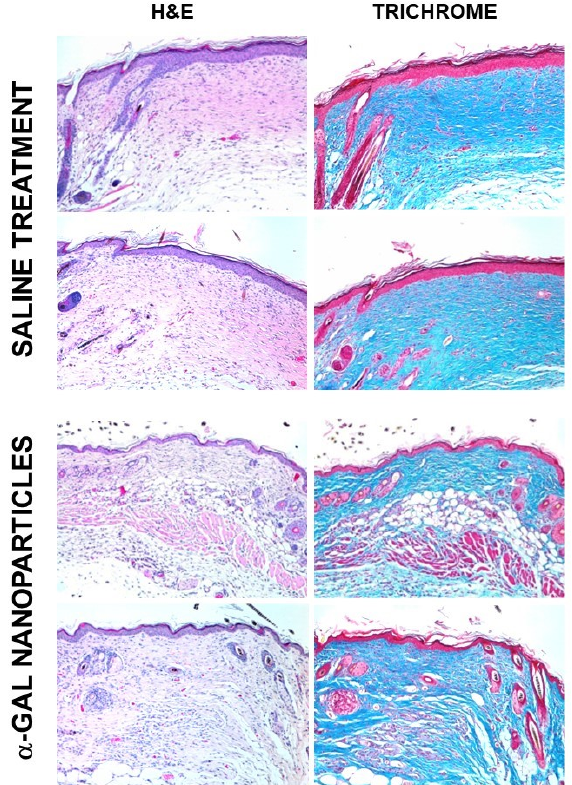
Figure 8. Histology of GT-KO mouse wounds treated with α -gal nanoparticles or with saline and inspected 28 days post treatment. Wounds were stained with H&E or with Masson trichrome for detection of de novo produced collagen. Whereas the saline treated wounds display distinct fibrosis and scar formation (dense connective tissue, hyperplastic epidermis, absence of skin appendages), the α -gal nanoparticles treated wounds display restoration of normal skin structure including growth of hair, loose connective tissue, adipose tissue and smooth muscle cells ( × 100). Reprinted from ref. [57] with permission.